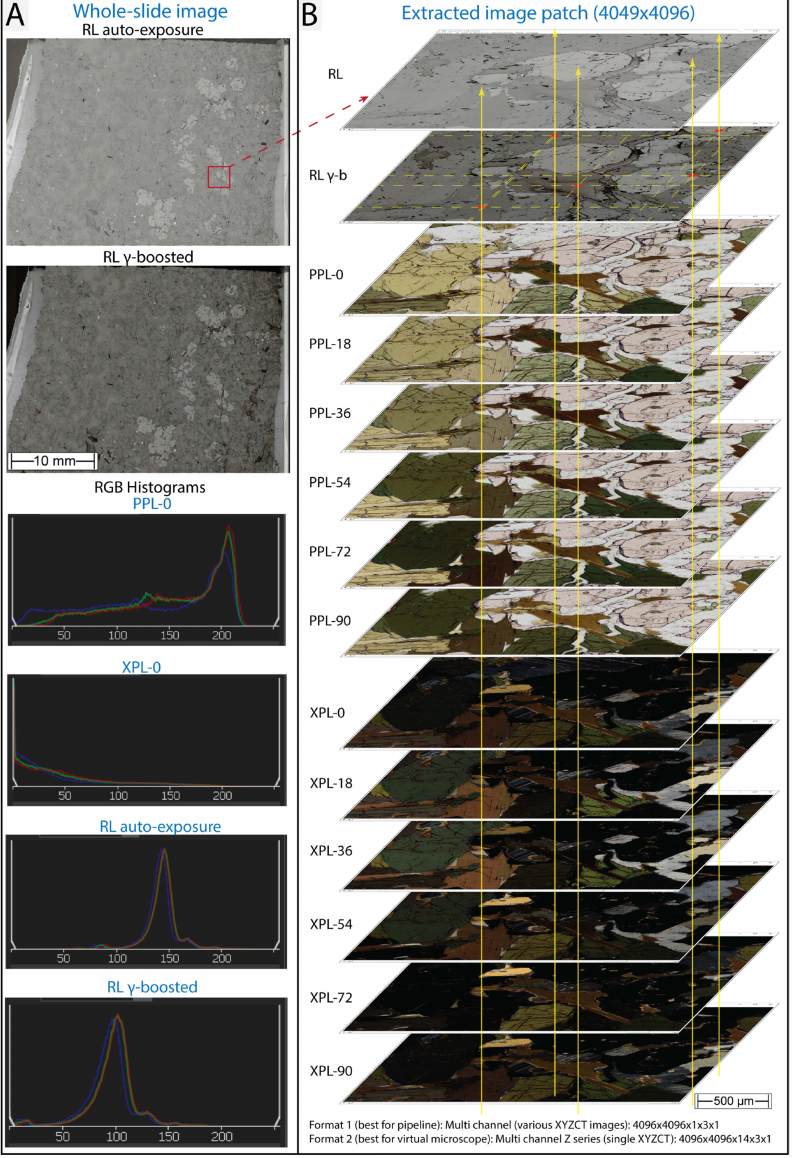
Figure 9. Imaging of a hornblende granulite. ( A ) Whole-slide images in RL auto-exposure and γ -boosted marking the position of a ROI (red square) ( top-left ) and RGB histograms of PPL-0, XPL-0, and both RL ( bottom-left ). RL γ -boosting allows for better distinguishing of dielectric minerals of low reflectivity. ( B ) Schematic drawing shows ray tracing in an image patch stack at five different sample locations (vertical yellow lines) of distinct mineralogy. The two typical image dimensionality options ( bottom-right ) are specified. Sample ID: